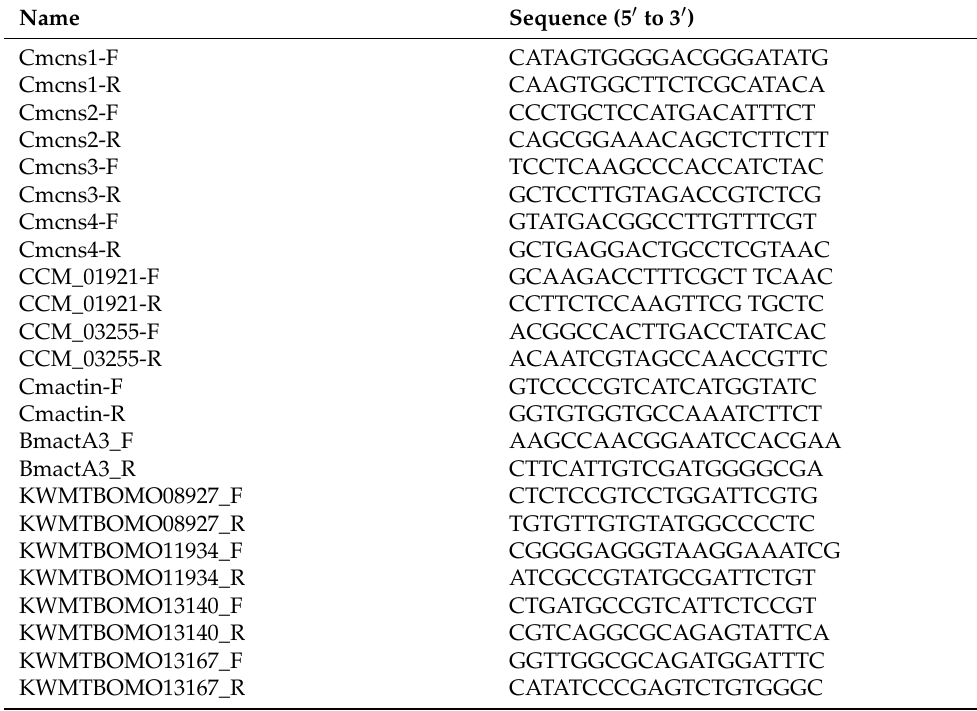
Table 1. Primers used in this